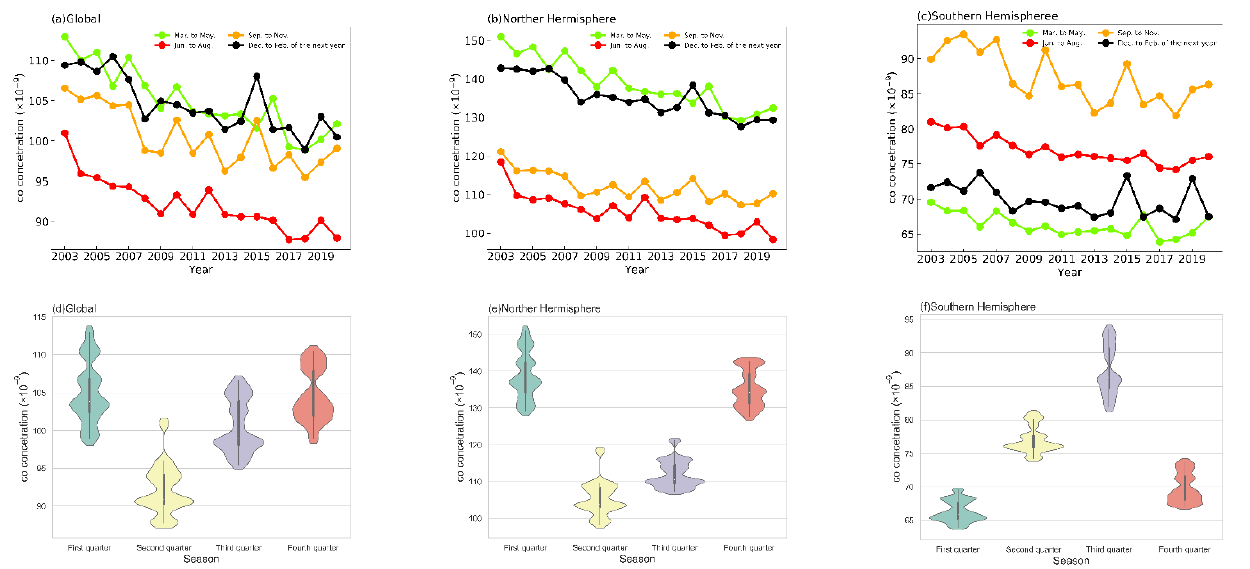
Figure 4. Line chart and violin chart of the four seasons change of the Global CO concentration 850 hPa pressure layer from 2003 to 2020. ( a , d ) Global; ( b , e ) northern hemisphere; ( c , f ) southern hemisphere. Table 1. Mean value, standard deviation, and minimum value and maximum value of CO concen- tration during the four seasons of the world, northern hemisphere and southern hemisphere from 2002 to 2020.